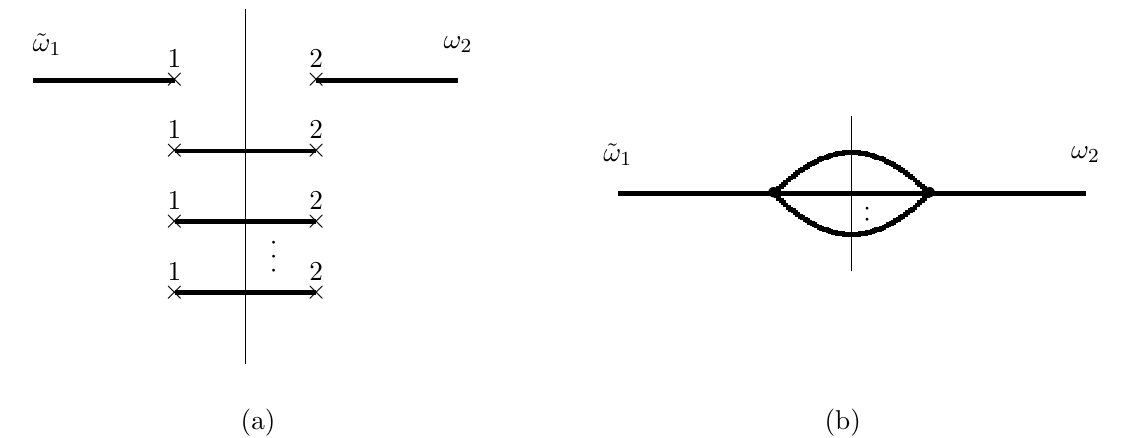
Figure 9 . (a) A cut diagram in open closed string field theory that can contribute to the imaginary part of the leading two instanton contribution to 1 → 1 closed string amplitude. The thin vertical line represents the cut. (b) The same cut diagram represented in the closed string effective field theory, with the • ’s representing the interaction vertices of this effective field